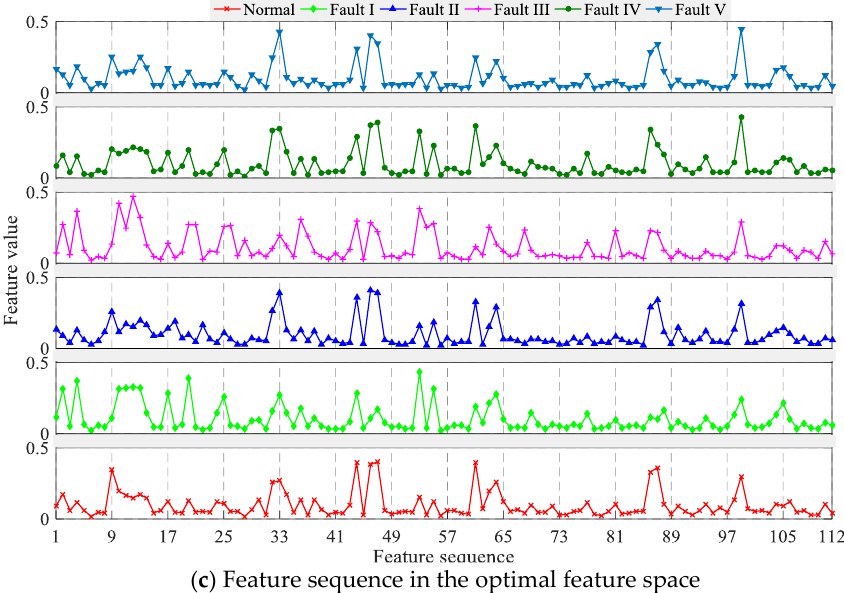
Figure 11. Calculation results of parameters of optimized feature space.